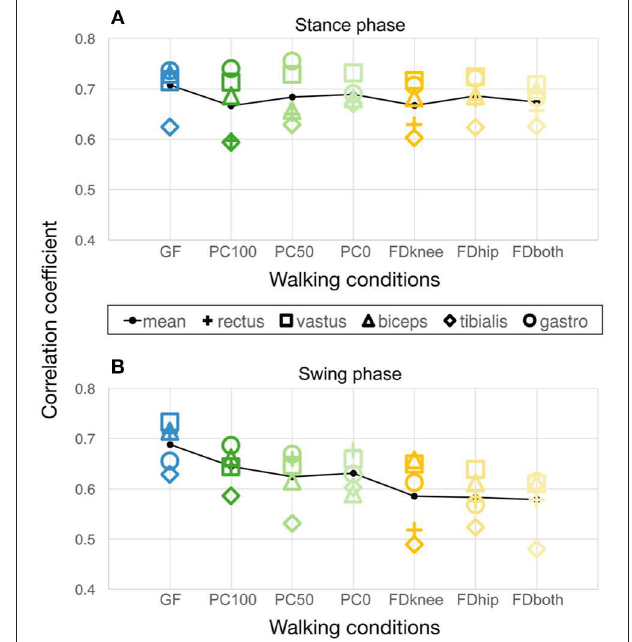
FIGURE 3 | Inter-step similarity of muscle activity patterns over 10 steps during (A) stance phase and (B) swing phase, respectively. The black line connects the average values of all correlations of the five measured muscles. GF, Guidance Force; PC, Path Control; FD FreeD; PC100 (and PC50 and PC0, respectively), Path Control with support force 100% (and 50 and 0%, respectively); FDknee, cuffs laterally moveable, pelvis fixated; FDhip, active pelvic translation/rotation, cuffs fixated; FDboth, cuffs laterally moveable and active pelvic translation/rotation; rectus, M. rectus femoris; vastus, M. vastus medialis; biceps, M. biceps femoris; tibialis, M. tibialis anterior; gastro, M. gastrocnemius